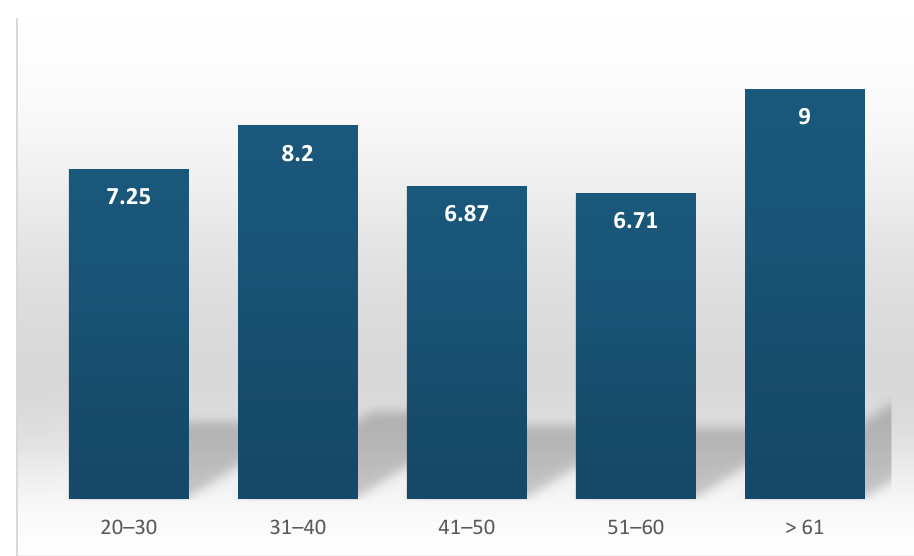
Figure 5. How AI can help journalistic work (scale: From 1 to 10).